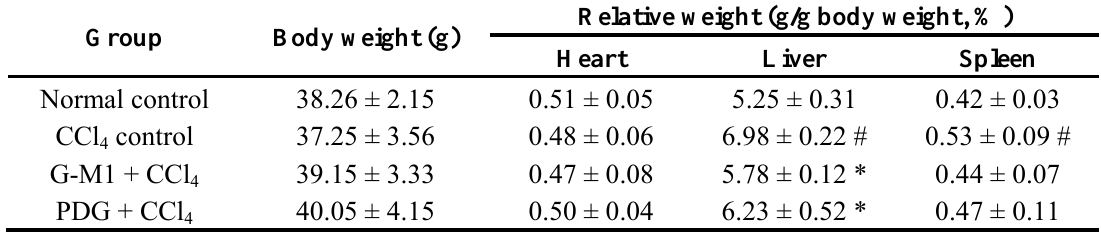
Table 1. Effects of PDG and G-M1 on body weight and relative organ weight in CCl -intoxicated mice. Mean ± 4